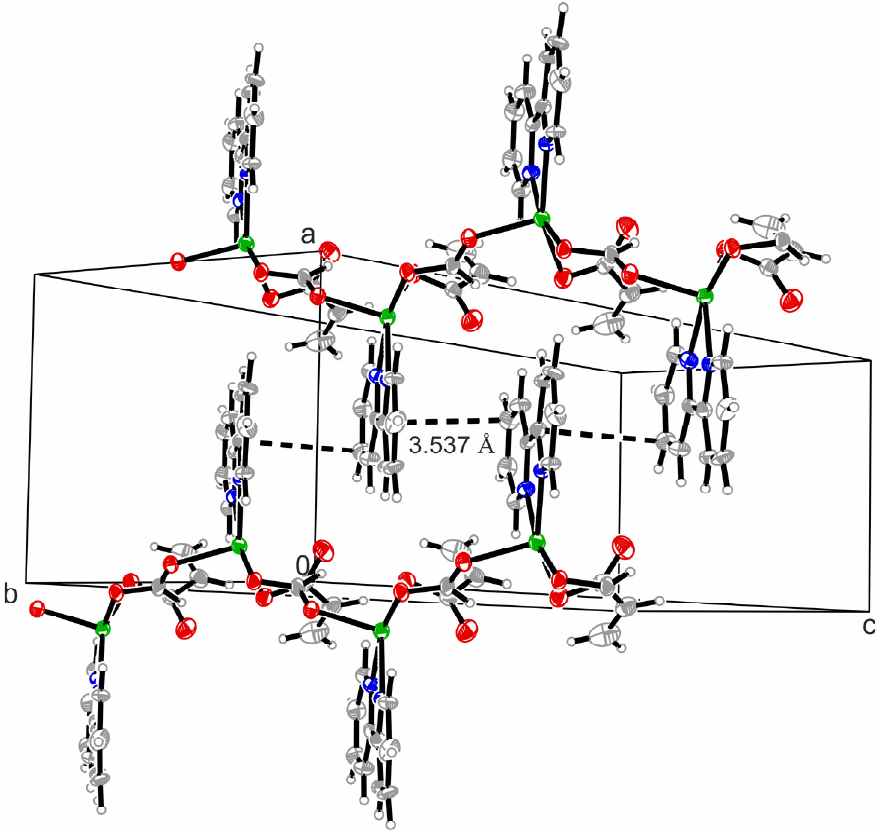
Figure 2. Excerpt of the packing diagram of compound ( 1a ) presenting the formation of linear chains involving π … π interactions between the molecules with suffix “A”.